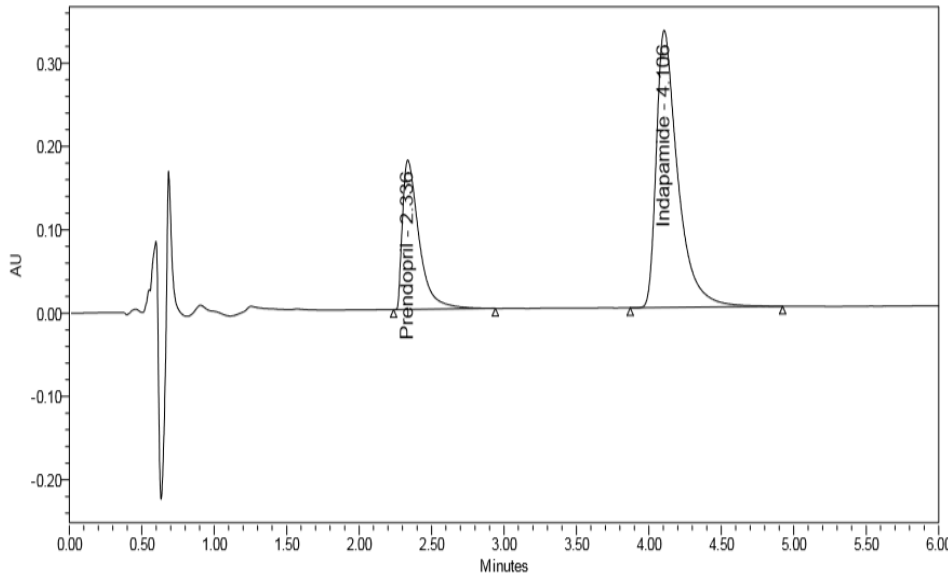
Figure 2. Complete resolution of Perindopril arginine and Indapamide Hemihydrate.